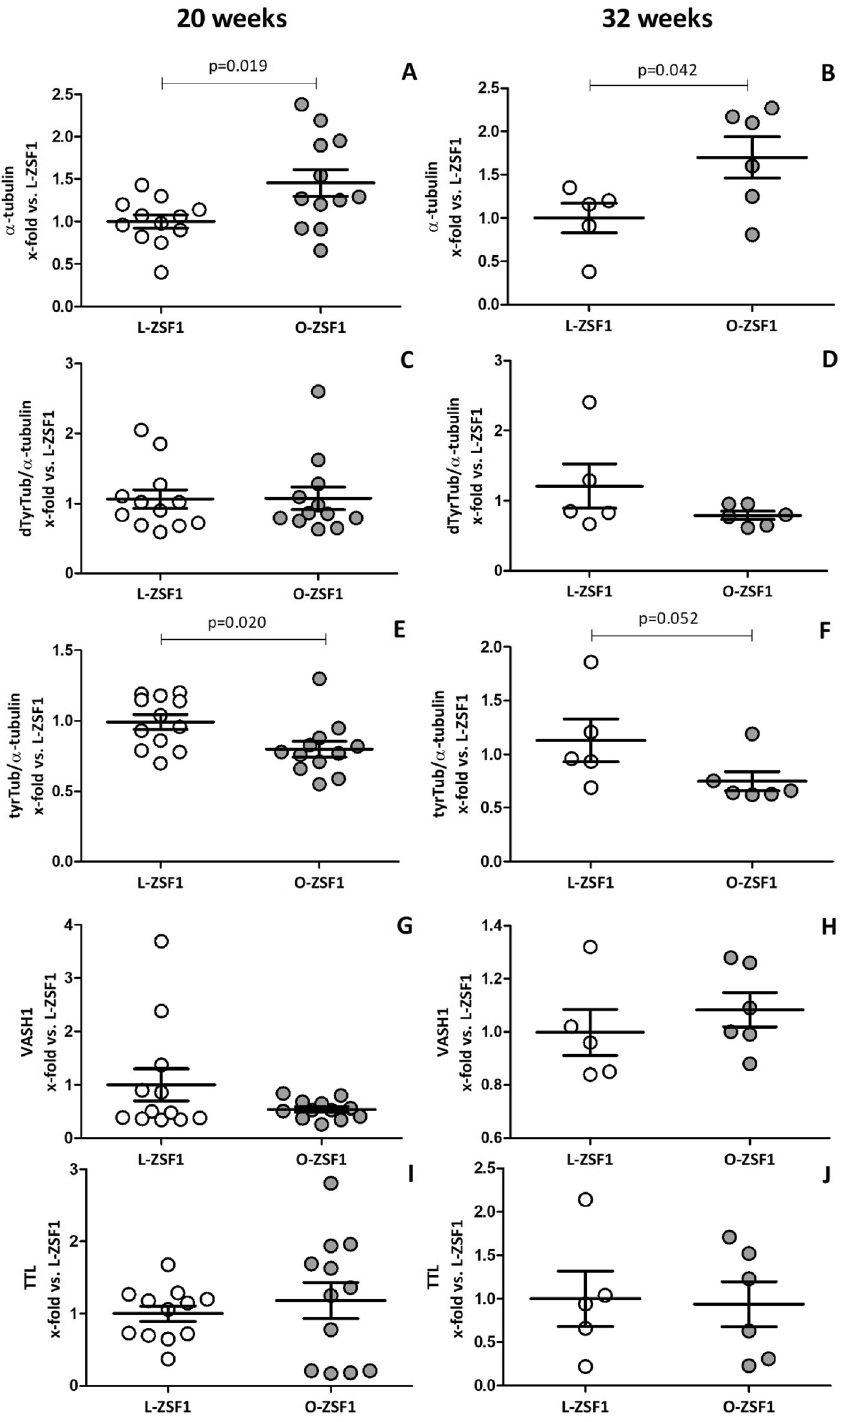
Figure 1. Protein expression of α-tubulin ( A / B ), ratios of detyrosinated tubulin/α-tubulin (dtyrT/α-tubulin) ( C / D ), tyrosinated tubulin/α-tubulin (tyrTub/α-tubulin) ( E / F ) and enzymes involved in tubulin detyrosination cycle namely tubulin carboxypeptidase vasohibin 1 (VASH1) ( G / H ) and tubulin tyrosin ligase (TTL) ( I / J ) measured in left ventricle tissue of O-ZSF1 and L-ZSF1 rats at an age of 20 weeks ( A / C / E / G / I ) and 32 weeks ( B / D / F / H / J ). Y-axis shows arbitrary units of protein expression normalised to GAPDH (for α-tubulin, detyrosinated and tyrosinated α-tubulin) or Histone H2B (for VASH1 and TTL). Further, measurements were normalised to the mean signal of all L-ZSF1 rats. Scatter plots represent the median, 25th and 75th percentiles. p -values were calculated using Student’s t-test (for normal distribution) and non-parametric Mann–Whitney- U -